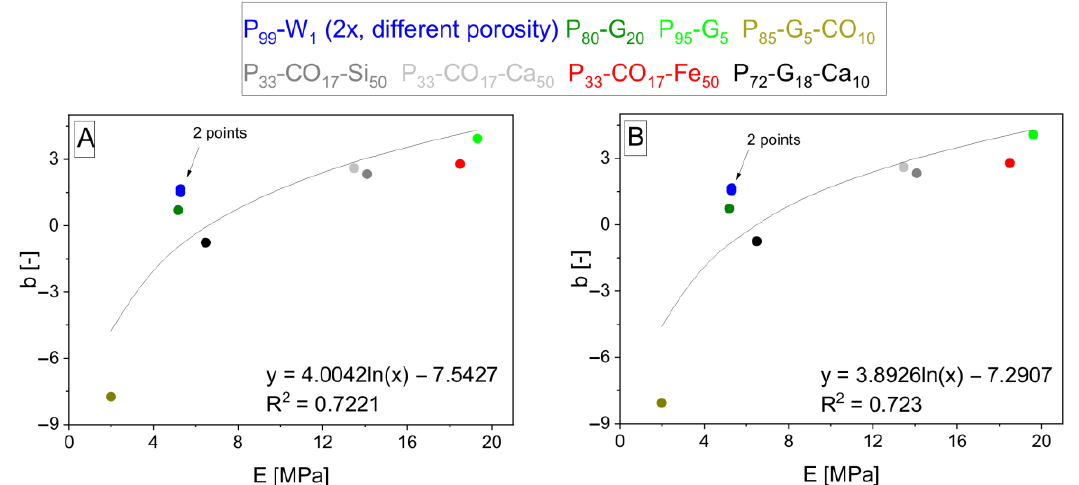
Figure 10. The logarithmic interpolation y = d + e · ln x of b parameters on E m . Parameters b were calculated by modified Equation (21) if the property z is specified as E , when E m values were taken from Table 4 according to Equations (10) – (11) ( A , B ) and the E mn and n m values were measured (see Table 2, used averages without deviations).